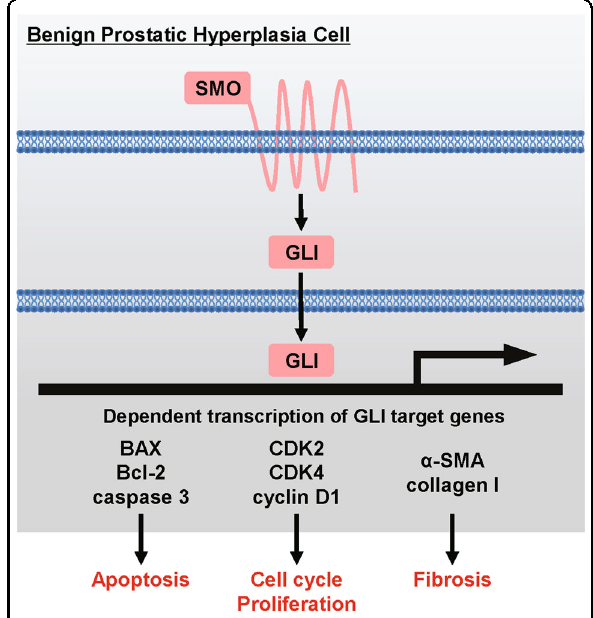
Fig. 8 Overview of SMO/GLI signaling cascades in benign prostatic hyperplasia. Canonical SMO/GLI signaling regulates the transcription of target genes, such as Bcl-2 , BAX , caspase-3 , CDK2/4 , cyclin D1 , α -SMA , and collagen I , which subsequently modulates apoptosis, cell proliferation, cell cycle, and fi brosis through the GLI- dependent transcription network in benign prostatic